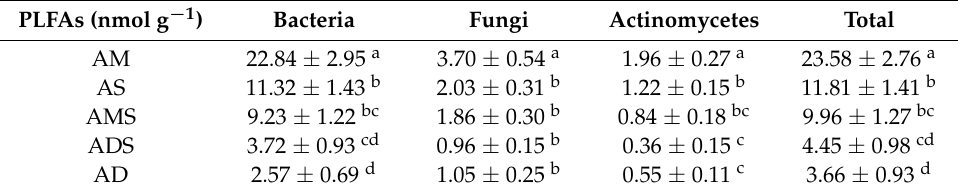
Table 2. The soil microbial composition characteristics of alpine grasslands in the Tibetan Plateau.